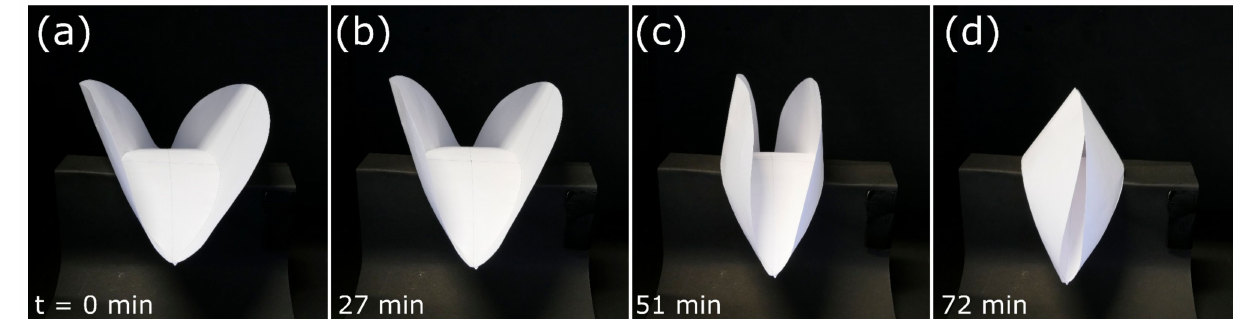
Figure 13. Self-actuated paper-based compliant system inspired by the snap-trap of the waterwheel plant ( A. vesiculosa ) performing closure upon drying. ( a – d ) Snapping sequence during desiccation. Times are indicated bottom left.